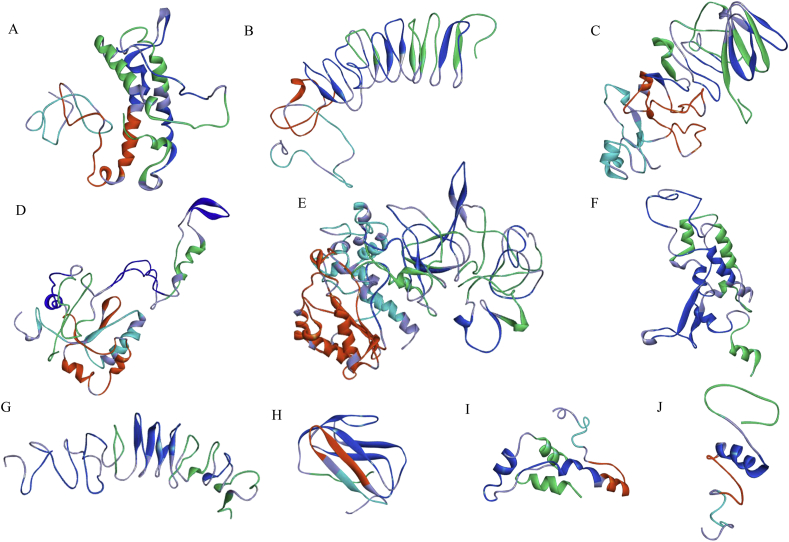
Molecular dynamics simulation study of final multi-epitope constructs representing root mean square deviation. A simulation was carried out for time duration of 20 ns. Representative graphs for construct 1, 2, 6 and 7 are provided.